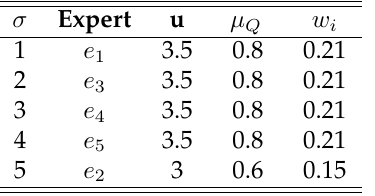
Table 3: Induced order and